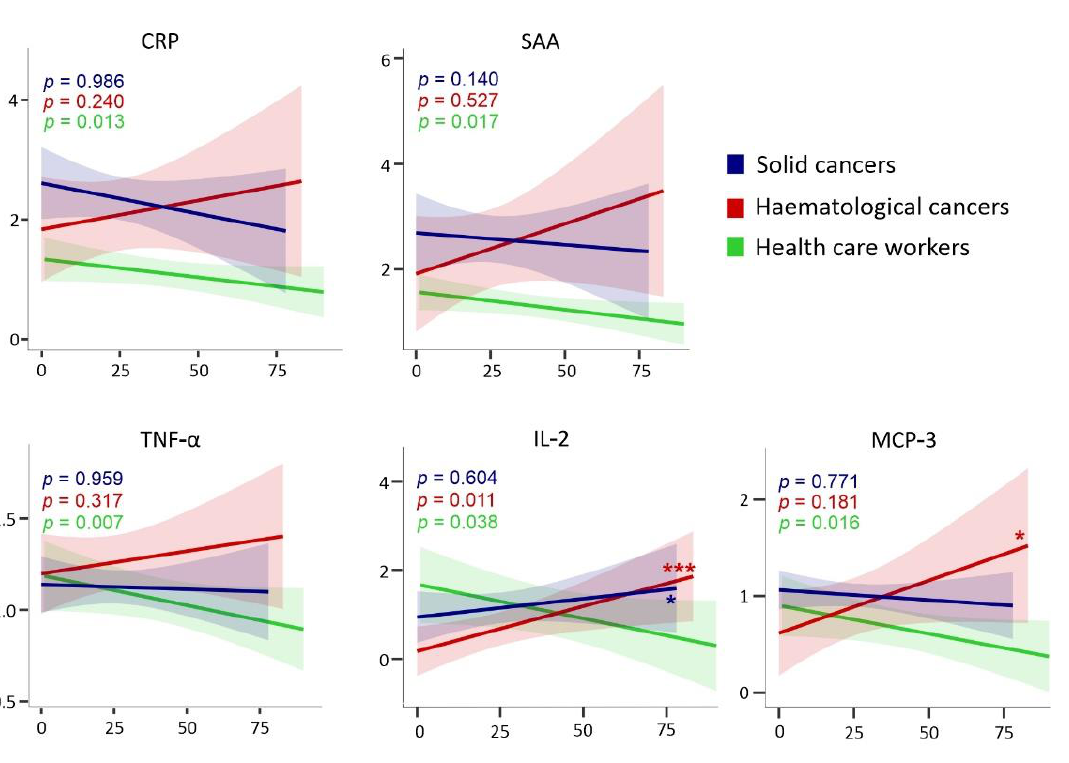
Figure 7. Temporal evolution of CCGs altered in exposed cancer patients. HCW, health care work- ers (green); solid, patients with solid tumours (blue); hemat, patients with haematological malig- nancies (red). Time is represented as days since symptom onset (day 0). p -values in the graph refer to significance of the slope from the 3 separate regression lines. The asterisks represent the signifi- cance of the pairwise comparison between the slope ( p -value for interaction) in haematological malignancy versus HCW (red) and solid malignancy versus HCW (blue). * p < 0.05, *** p < 0.001. 4. Discussion In a highly diverse set of cancer types representing the most common types of solid as well as haematological malignancies, we identified distinct immunological profiles of CCGs in these two types of cancers. While 19 CCGs were elevated in both solid and hae- matological malignancy patients, a further 15 CCGs were uniquely upregulated in solid tumours while only one CCG (IL-18) was uniquely upregulated in haematological malig- nancies. In addition, only one CCG (angiopoietin receptor Tie-2) was also significantly